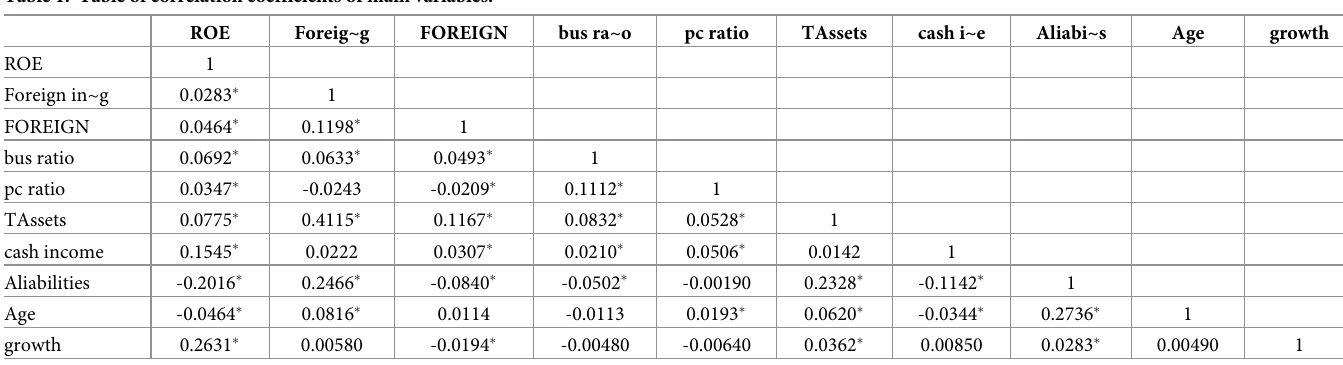
Table 1. Table of correlation coefficients of main variables.